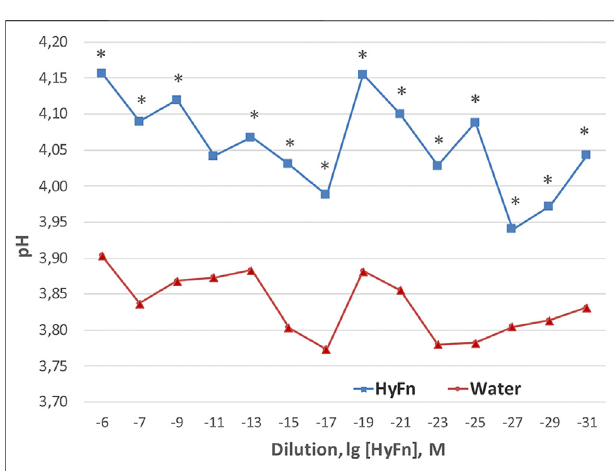
FIGURE3| pHvaluesintheseriesofHyFndilutionsandwater “ dilutions ” after addition of eight 10 μ L portions of HCl to each HyFn dilution and respective water “ dilutions. ” Each curve is an average over all 6 series of measurements. * p < 0.01 for the difference between HyFn dilutions and respective water “ dilutions ” according to Mann-Whitney U test. Abscissa depicts sequential dilutions corresponding to calculated lg [HyFn],